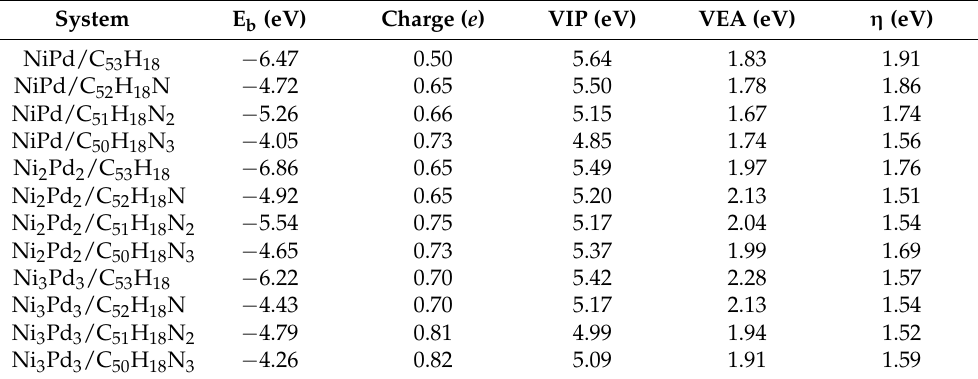
Table 2. Properties of Ni n Pd n (n = 1 − 3) supported on graphene with defects.